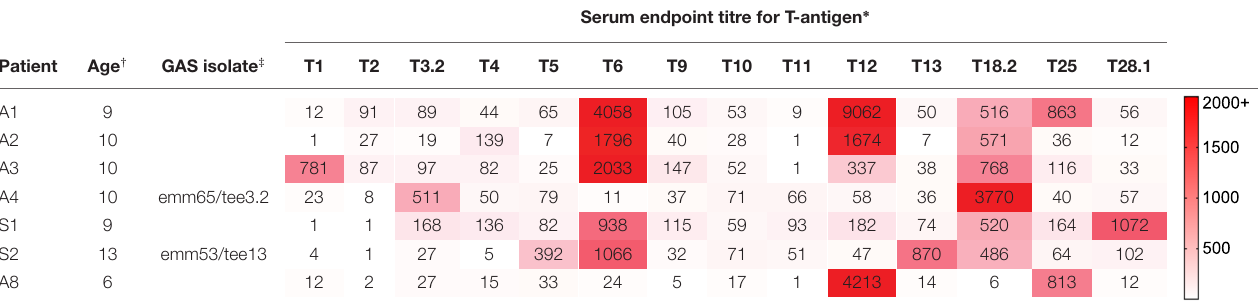
TABLE 1 | Serum IgG endpoint titre of rheumatic fever patient sera against a panel of 14 recombinant Group A Streptococcus (GAS) T-antigens. Serum endpoint titre for T-antigen